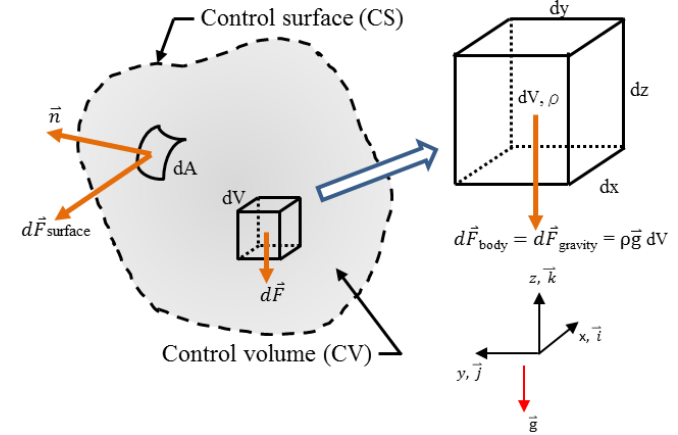
Figure 2. Force distribution on the fluid.